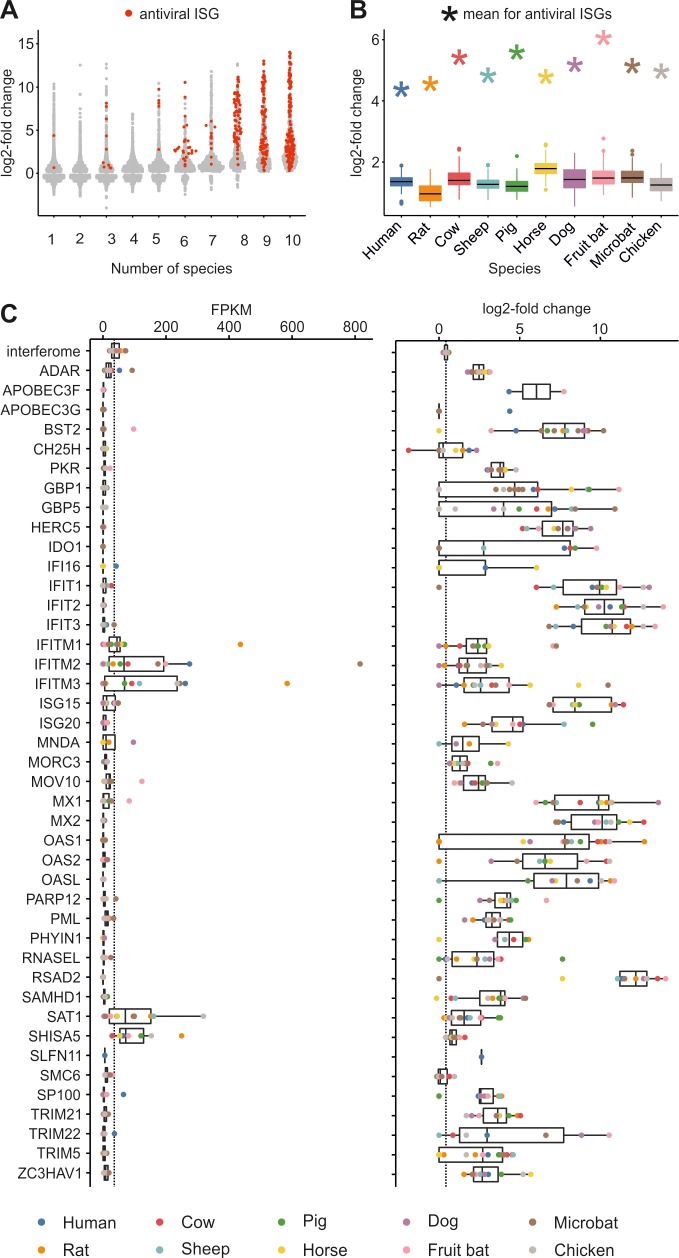
Properties of antiviral ISGs.(A) Sinaplot showing the differential expression values (log2FC) of 40 genes previously published as exerting antiviral activity (red dots) (S2 Table) as opposed to the rest of the ISGs (grey dots). ISGs (including antiviral ISGs) were allocated to bins according to the number of species in which they were found to be up- or down-regulated (i.e., the corevert ISGs are bin 10). The majority of antiviral ISGs (red) were found to be up-regulated in at least eight species (S1 Data). (B) Graph showing the extent of up-regulation of antiviral ISGs compared to nonantiviral ISGs. The mean log2FC of 40 known antiviral ISGs (indicated with an asterisk on the plot) is compared to 100 samplings of 40 randomly selected ISGs from the interferome of each species (box and whiskers). In all cases, antiviral ISGs are up-regulated to a significantly greater extent as compared to nonantiviral ISGs (P < 0.01 for each species). The code used for random sampling and the generation of Fig 3B is available in S2 Data, with the required input files available as S5 Data and S6 Data. (C) Boxplots showing basal transcription levels (expressed as FPKM) and differential expression (log2FC) in response to IFN of known antiviral ISGs as in panels A and B. Every ortholog for each gene is indicated with a dot coloured according to species. The median FPKM value for the entire interferome is indicated with a broken line (S1 Data). FPKM, fragments per kilobase mapped values; IFN, interferon; ISGs, interferon-stimulated genes; log2FC, log2 fold change.